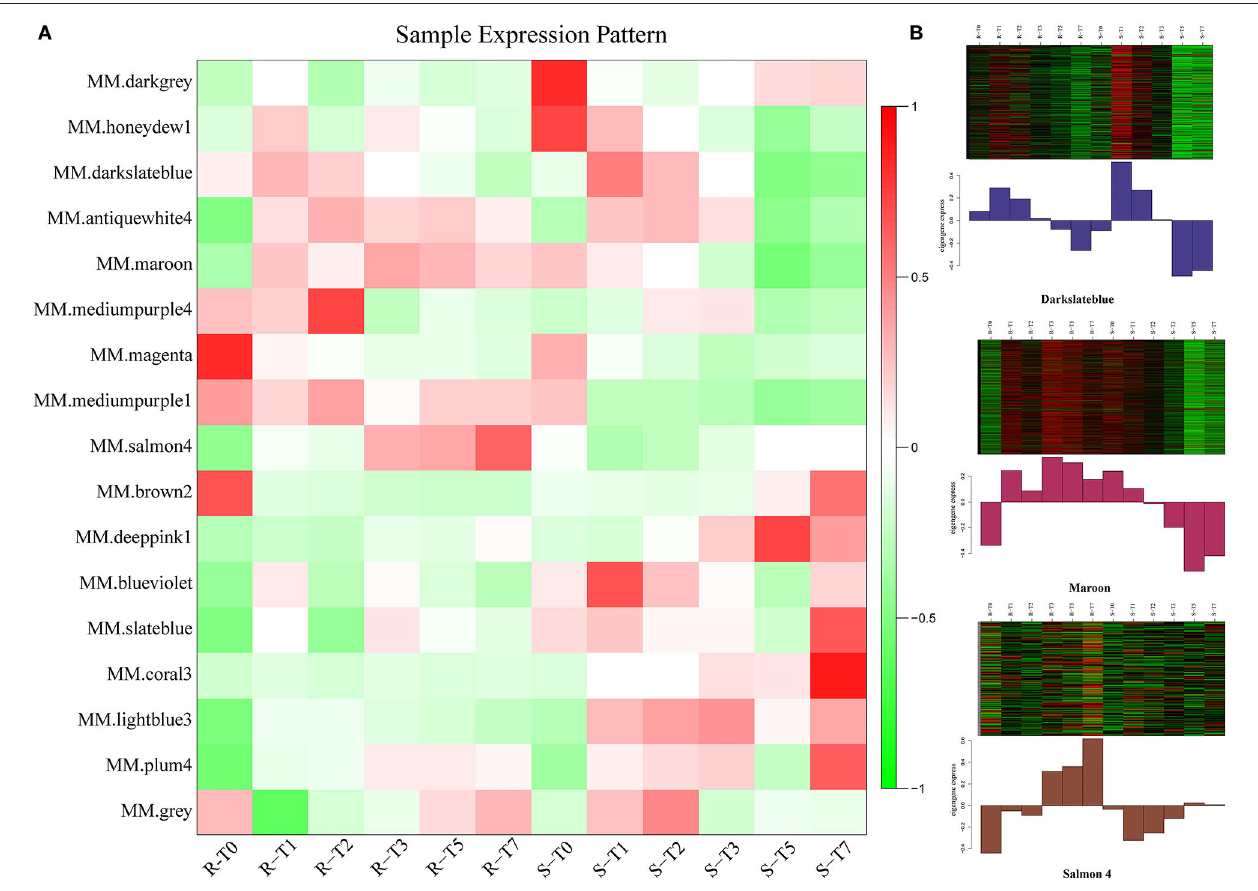
FIGURE 6 | Expression patterns of genes in modules. (A) Heatmap of sample expression pattern. (B) Expression patterns in key modules at different time-points post-inoculation.